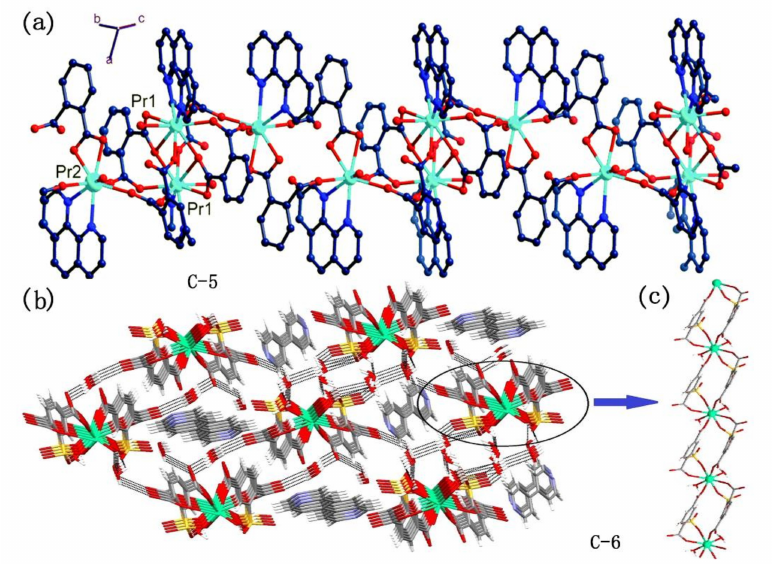
Figure 12. ( a ) A view of the molecular structure of complexes C-5 ; ( b ) a view of 3-D hydrogen bond network of C-6 in bc plane. Uncoordinated 4,40-bipyridine molecules occupy the channels; ( c ) a view of 1-D infinite chain along a axis constructed by C-6 . ( a ) Reprinted with permission from [60], Copyright 2019, Feng, X. et al. ( b , c ) Reprinted from [62], Copyright 2016, with permission from Elsevier.